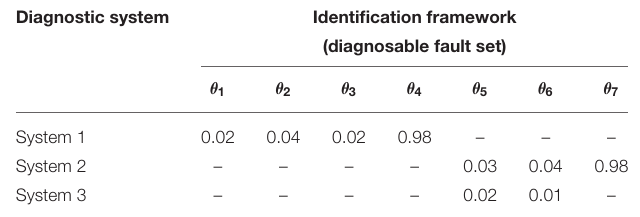
TABLE 3 | Fusion examples.